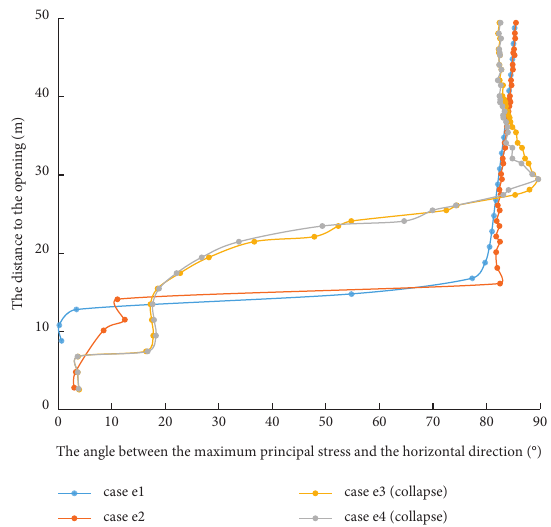
Figure 14: The relationship between the direction of the maximum principal stress and the distance to the opening.